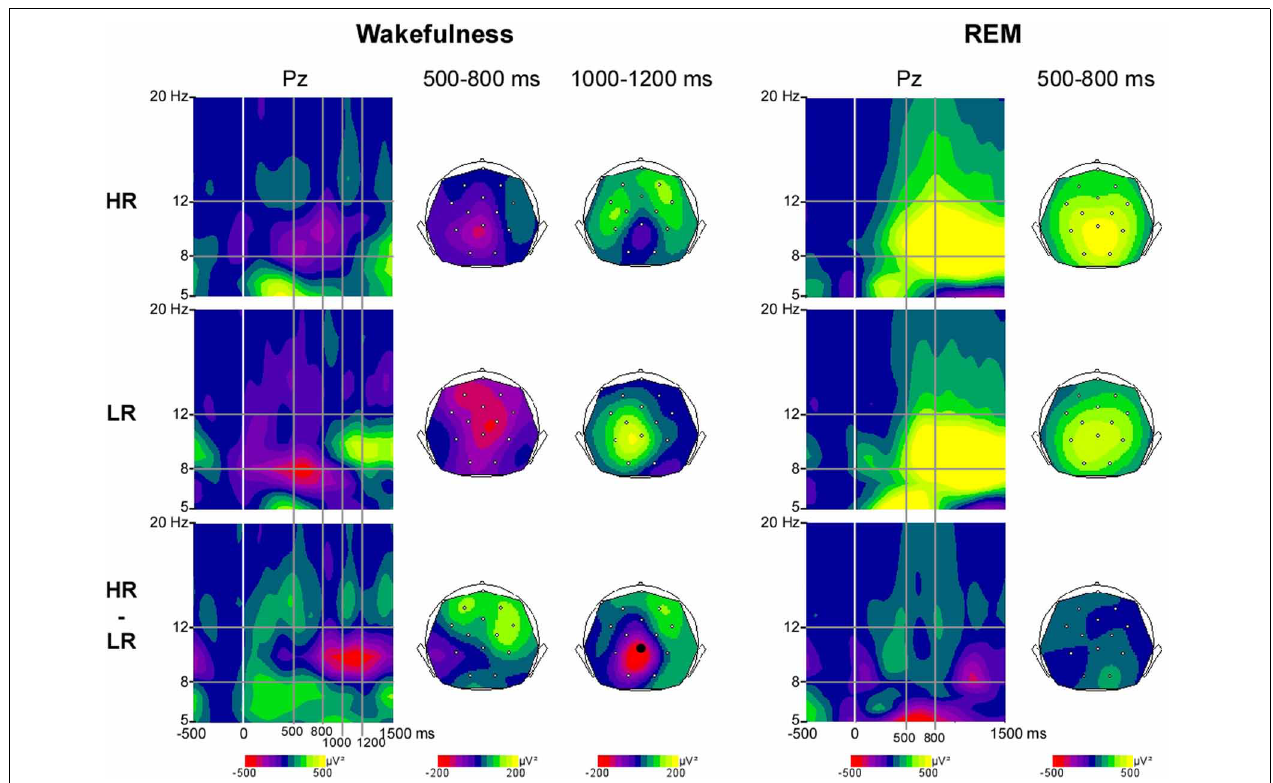
FIGURE 1 | Alpha power induced by first names during wakefulness and REM sleep in High-recallers and Low-recallers. Time-Frequency(TF) plots for first names in HR, LR and HR minus LR, during wakefulness and REM sleep, at the electrode Pz, after baseline correction (baseline defined from − 300 to − 100ms). x-axis: time, y-axis: frequency, the vertical white line indicates stimulus onset. Scalp topographies (back views) of alpha power are